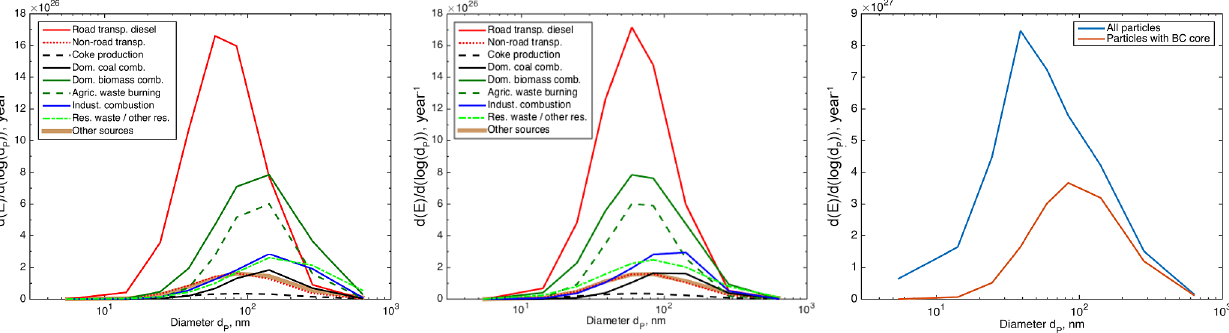
Figure 7. Estimated global number size distributions of the black carbon mode particles (left panel) and of their black carbon cores, assuming only OC is condensing on the BC cores (middle panel). Number size distribution of global total PN emissions and emissions of particles with BC core (right panel). The source categories in the left and middle panels are the same as in Fig.